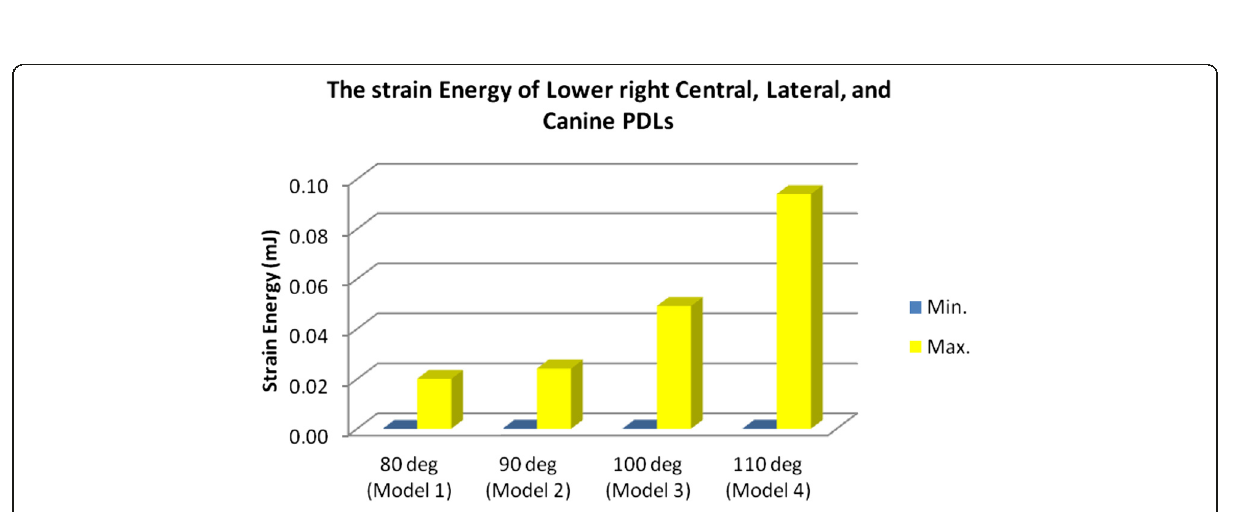
Fig. 11 The strain energy of the lower right central, lateral, and canine PDLs